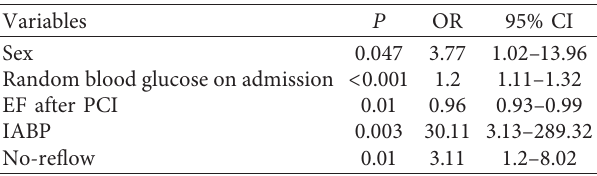
Table 2: Variables selected as predictors for the nomogram according to the multivariable logistic analysis.